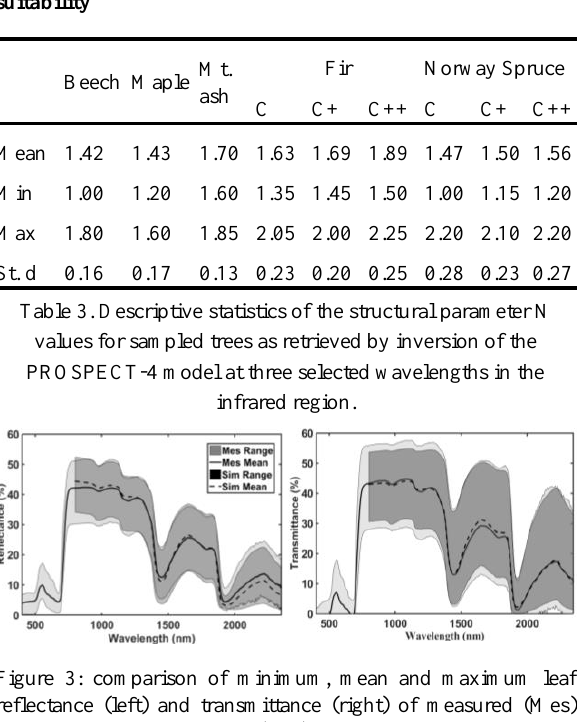
Figure 4. Root Mean Square Errors (RMSE) computed between the measured and PROSPECT simulated reflectance and transmittance samples.